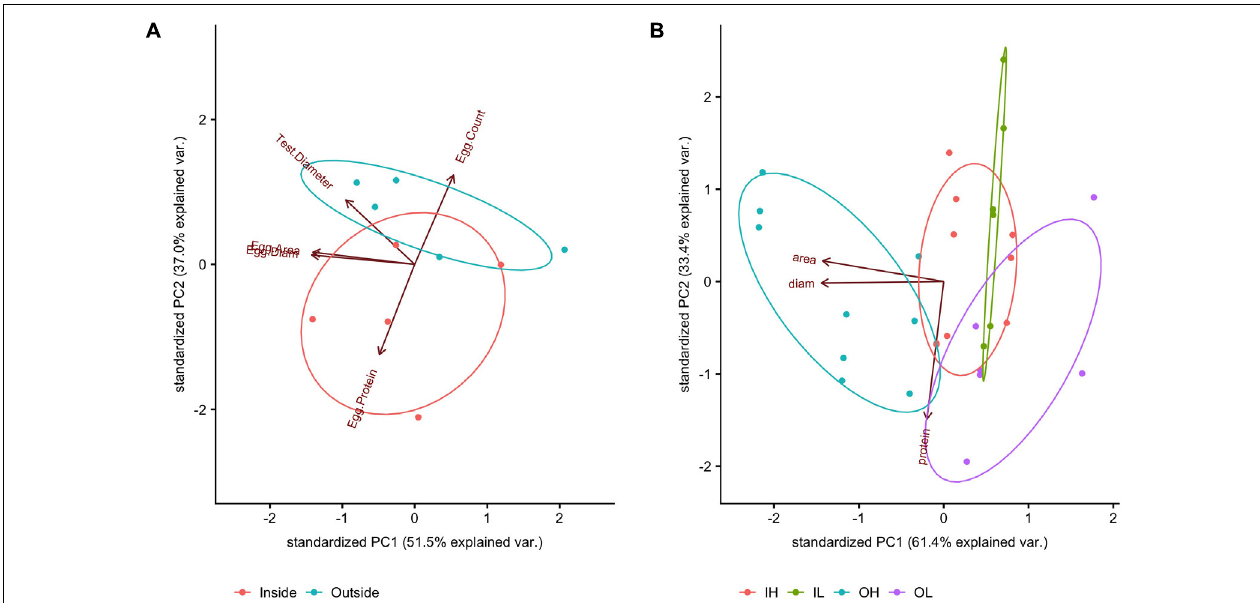
FIGURE 8 | PCA of measurements at the (A) egg level (egg average protein, egg area, egg diameter), averaged to match measurements at the individual female level (egg count, test diameter); PCA of measurements taken of (B) hatched blastula embryos (17 hpf). OH was significantly different from the other treatments (FDR post hoc test). Absolute values can be found in Supplementary Table 2